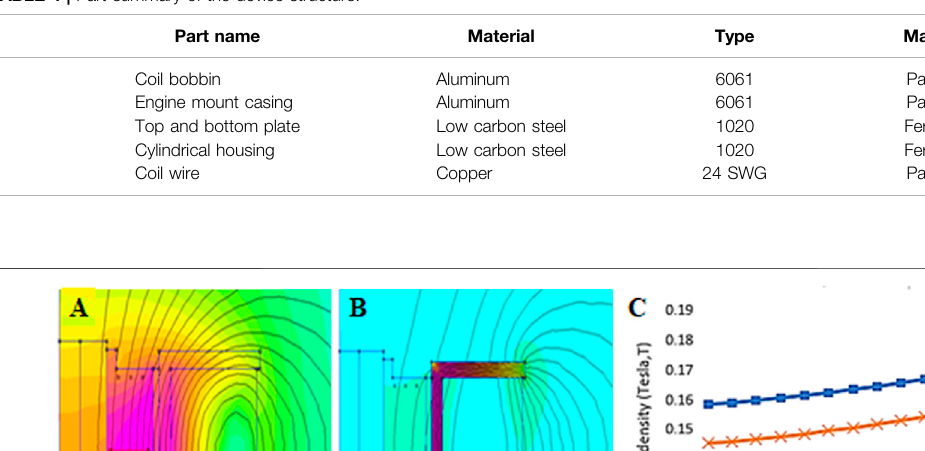
TABLE 4 | Part summary of the device structure.